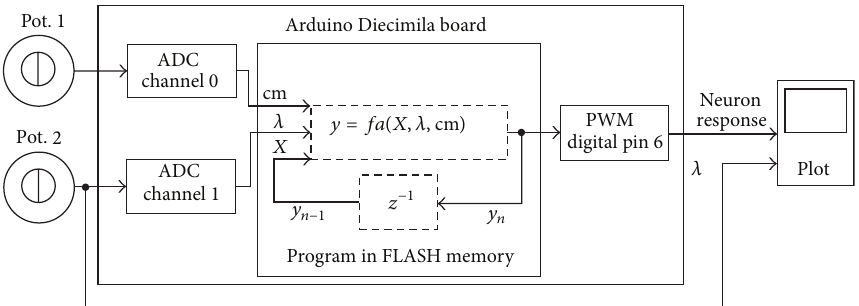
Figure 9: Schematic diagram of the